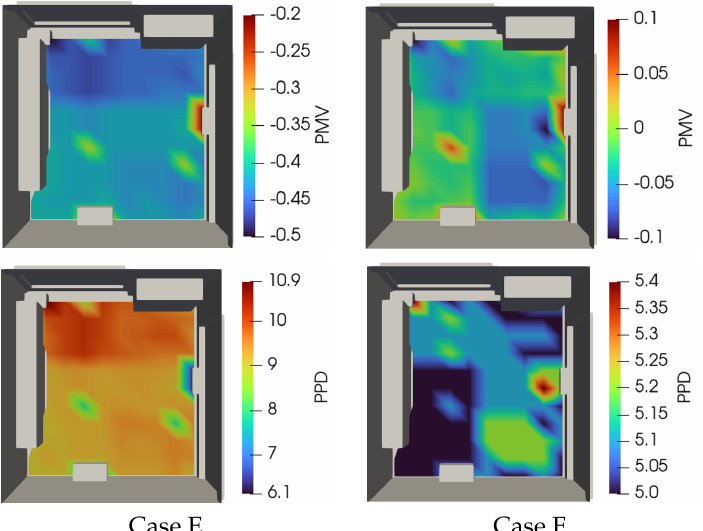
Figure 16. Winter heating condition. PMV (top subfigures) and relative PPD (bottom subfigures) distributions along the office obtained with low input air velocity (Case E) and high input air velocity (Case